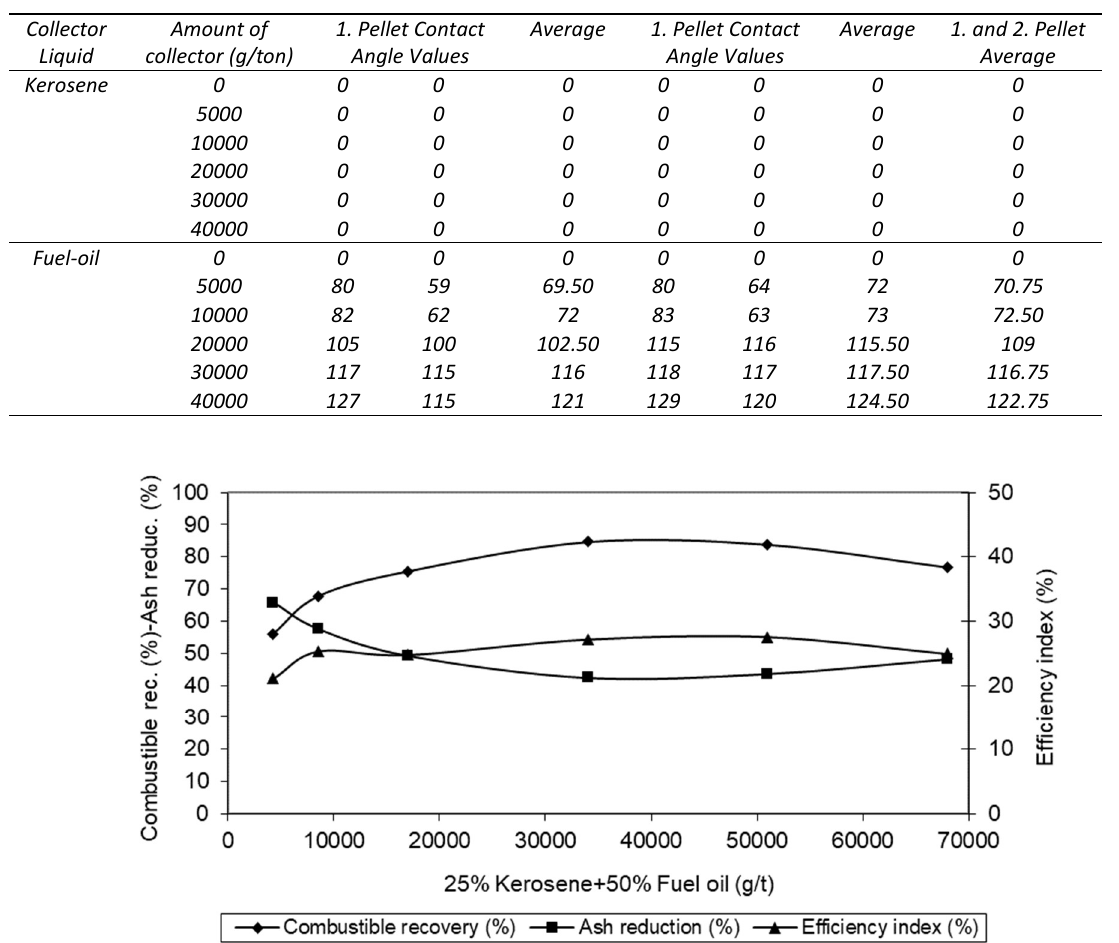
Contact angle values obtained from Soma Lignite coal samples treated with oils Collector